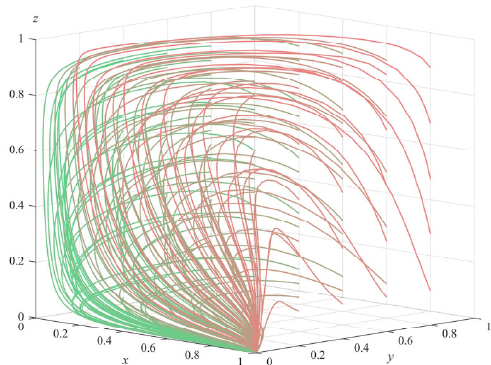
Figure 2. Simulation results of Proposition 2. (3) Numerical simulation of